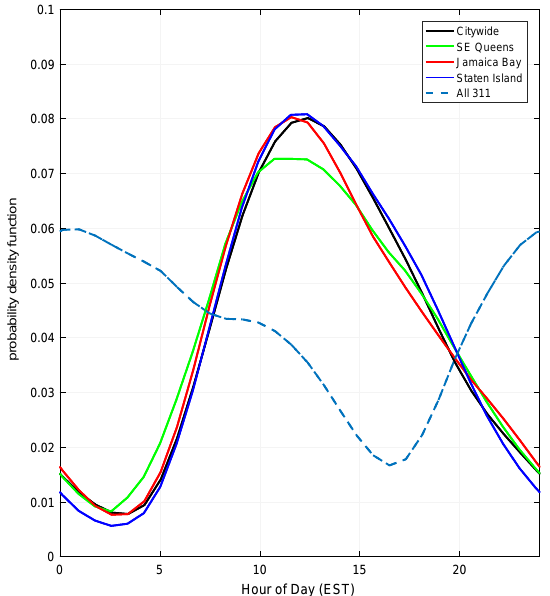
Figure 7. Probability density function for the diurnal variation in 311 reports. “Citywide” represents city-wide flood reports, “Southeast (SE) Queens Jamaica Bay and Staten Island” represent flood reports in these areas (see Figure 2), and “All 311” represents any 311 complaint. EST stands for Eastern Standard